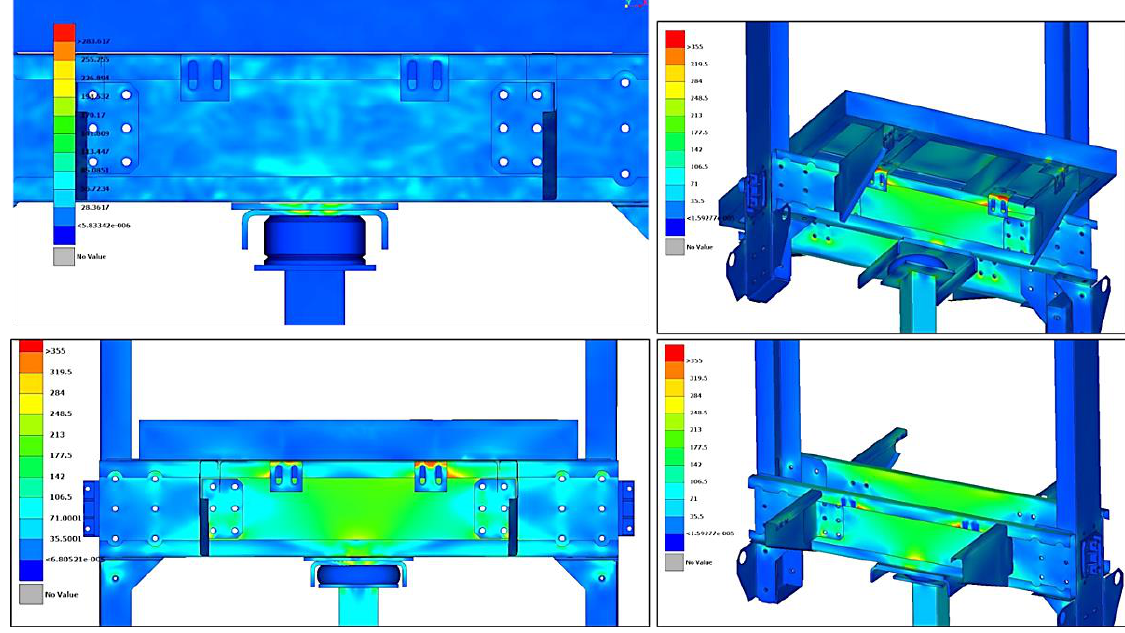
Figure 10. Distribution of equivalent von-Mises stresses on the test-case chassis.